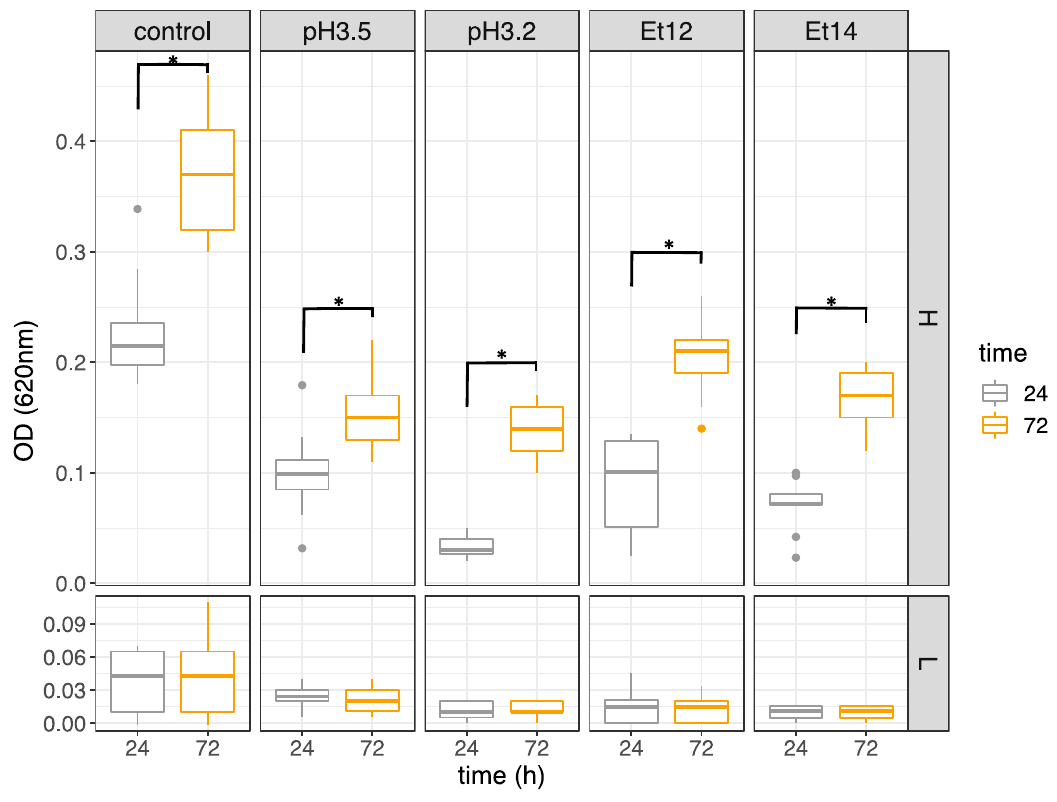
Figure 3. Effect of incubation time (24 h vs. 72 h) on L. plantarum biofilm formation. Strains are grouped in high (H) and low (L) biofilm producers. * indicates significant differences ( p < 0.05). OD, optical density.